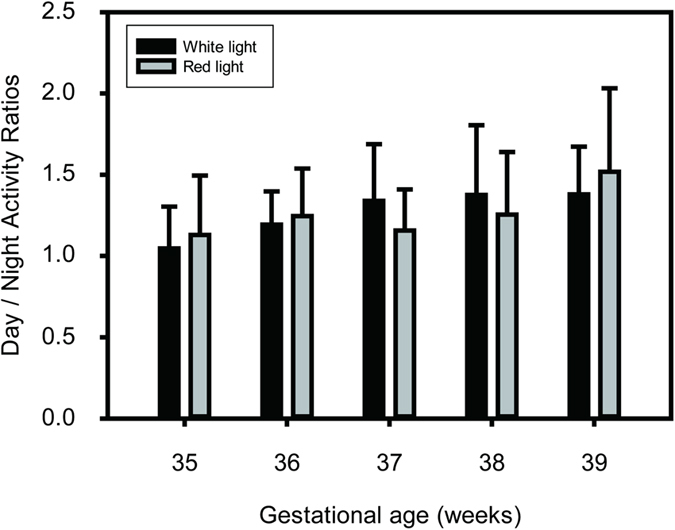
Day-night activity ratios over consecutive 7-day periods, at 35, 36, 37, 38, and 39 weeks of gestational age (WGA).Dark bars: control infants exposed to white LED light during night; gray bars: experimental group infants exposed to red LED light during night (mean ± s.d.). Observe that exposure to either white or red LED light results in similar patterns of increased daytime activity over nighttime activity over each range of days.